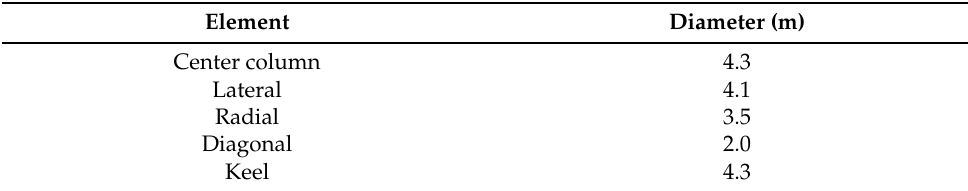
Table 1. Definition of diameters of the foundation